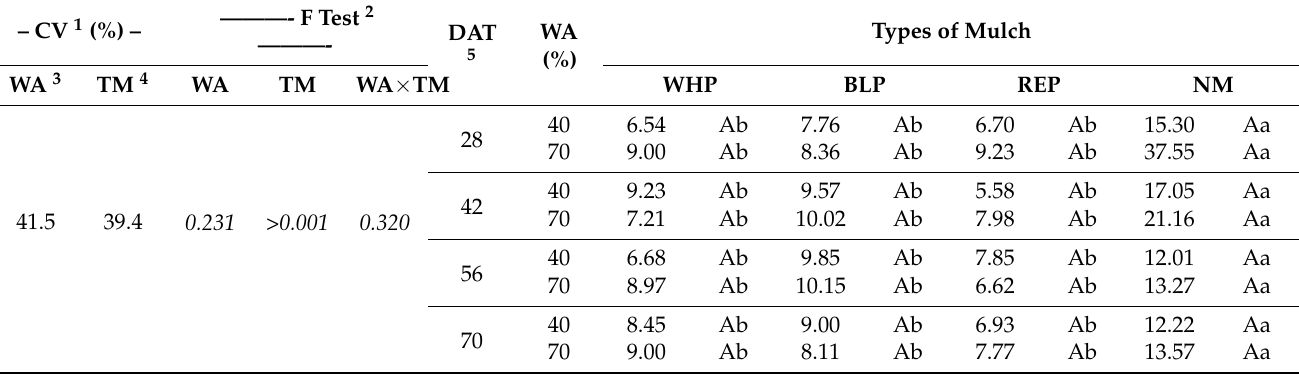
Table 4. Weed shoot dry biomass (g m − 2 ) at four different times and as a function of wet area and